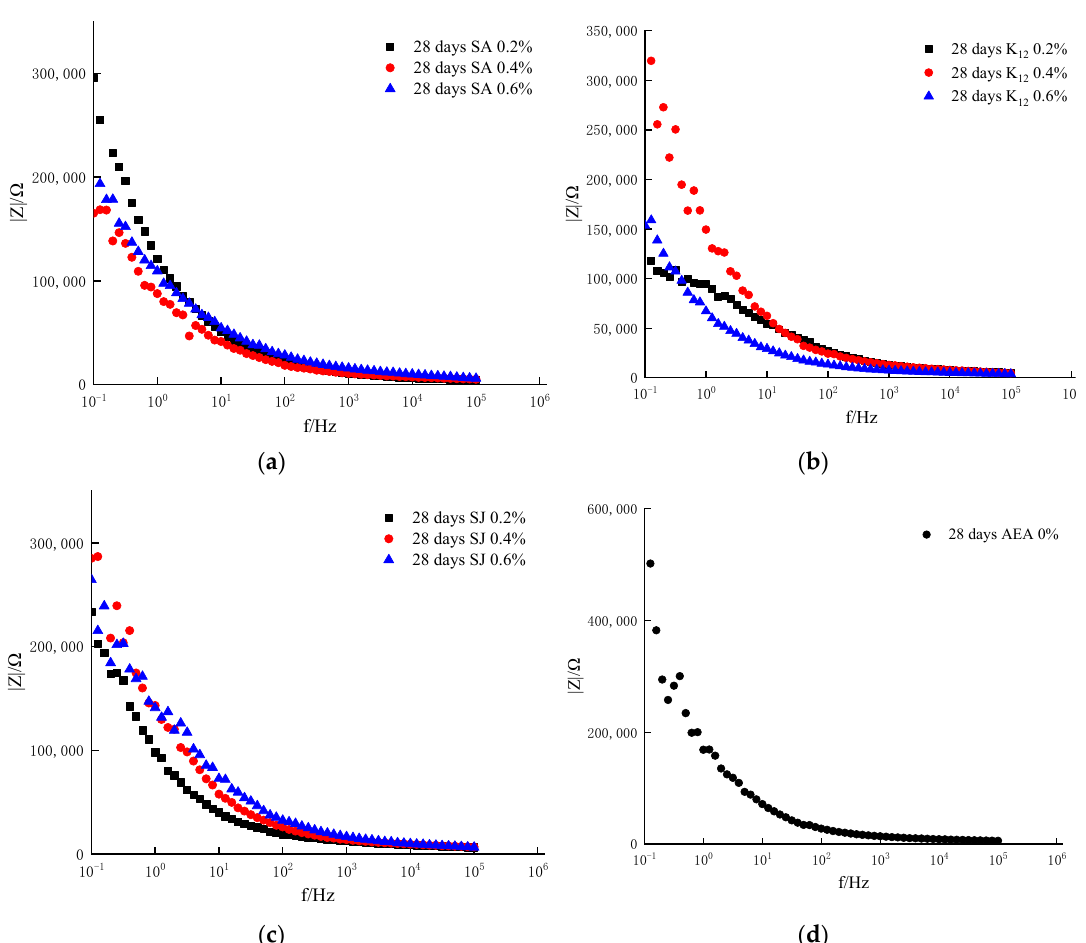
Figure 5. Relationship between AC impedance value and frequency of filling test block with different AEA added for 28 days of curing age. ( a ) Add SA; ( b ) Add K 12 ; ( c ) Add SJ; ( d ) 0% AEA.